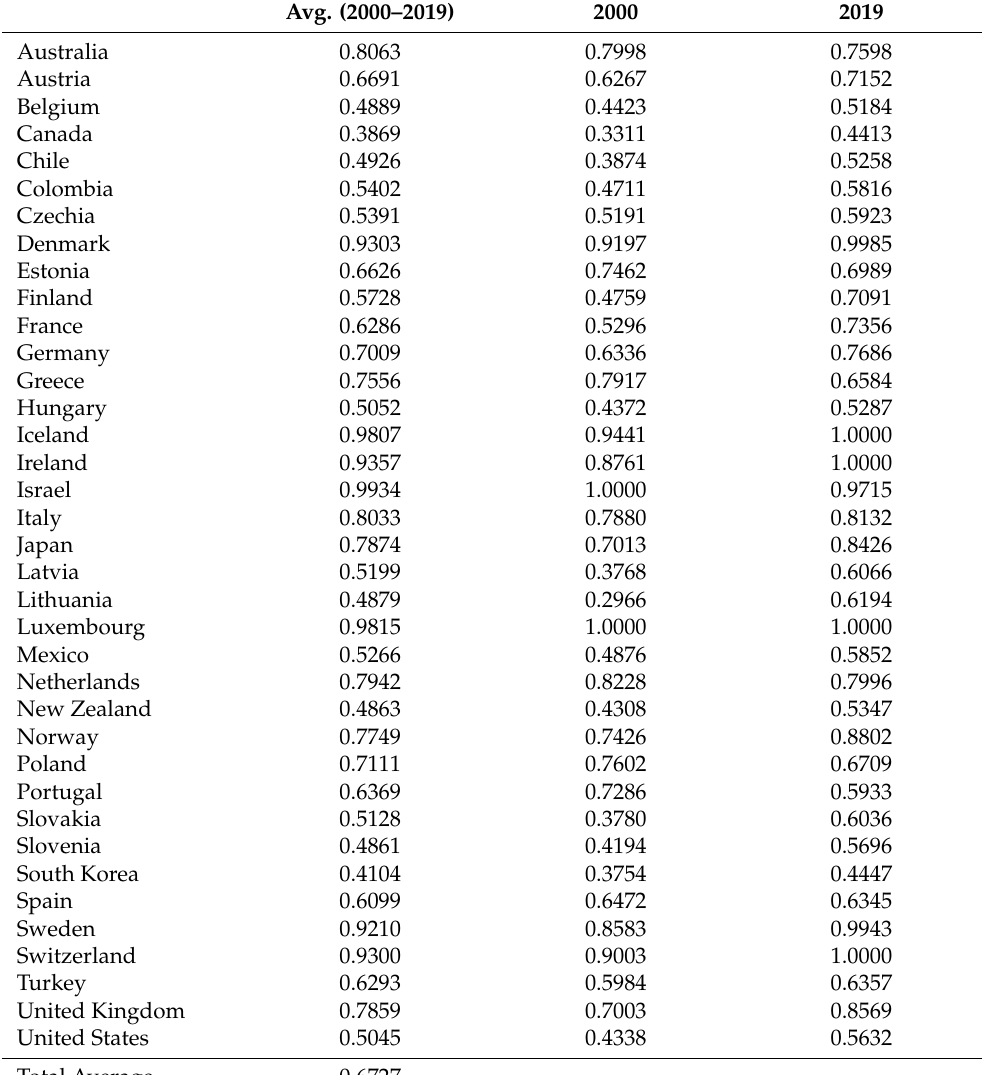
Table 4. Efficiency ( CSOE ) measures of OECD nations: Model